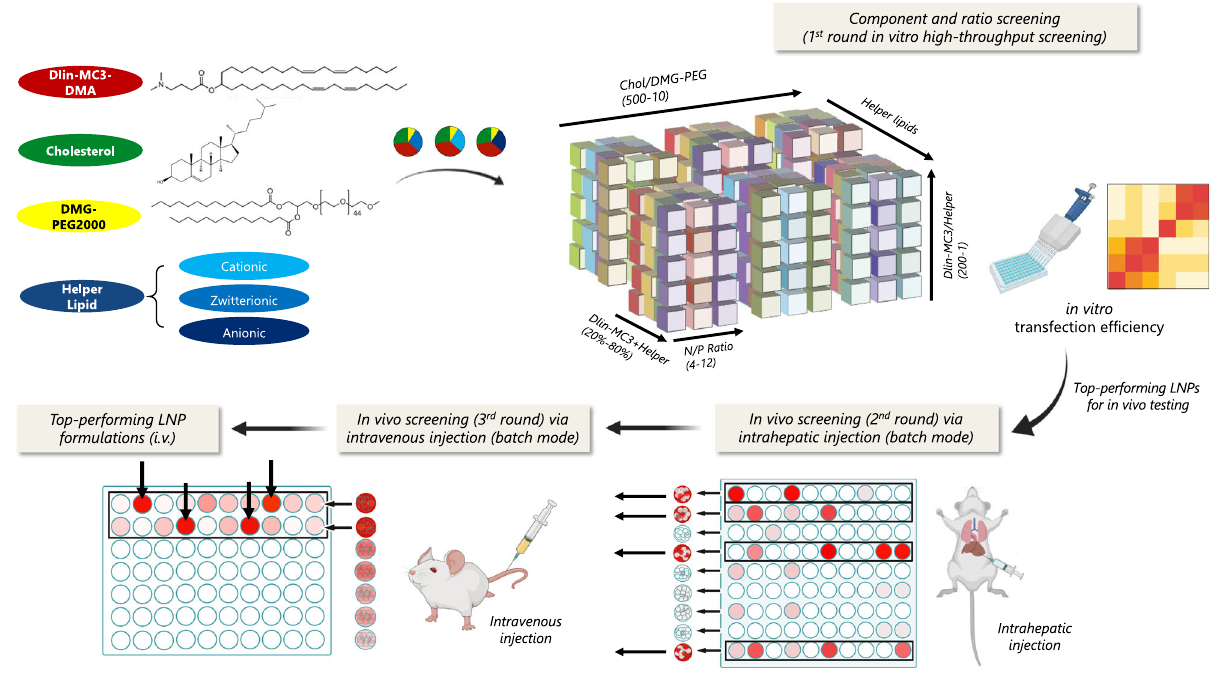
Fig. 1 | Schematic illustration of multi-step composition screening of lipid nanoparticles (LNPs) for liver-targeted pDNA delivery. In vitro transfection ef fi ciency was assessed for 1080 LNP formulations with different helper lipids and component ratios. The top-performing formulations for each helper lipid series werethentestedinclustersforcytotoxicityandinvivolocaltransfectionef fi ciency